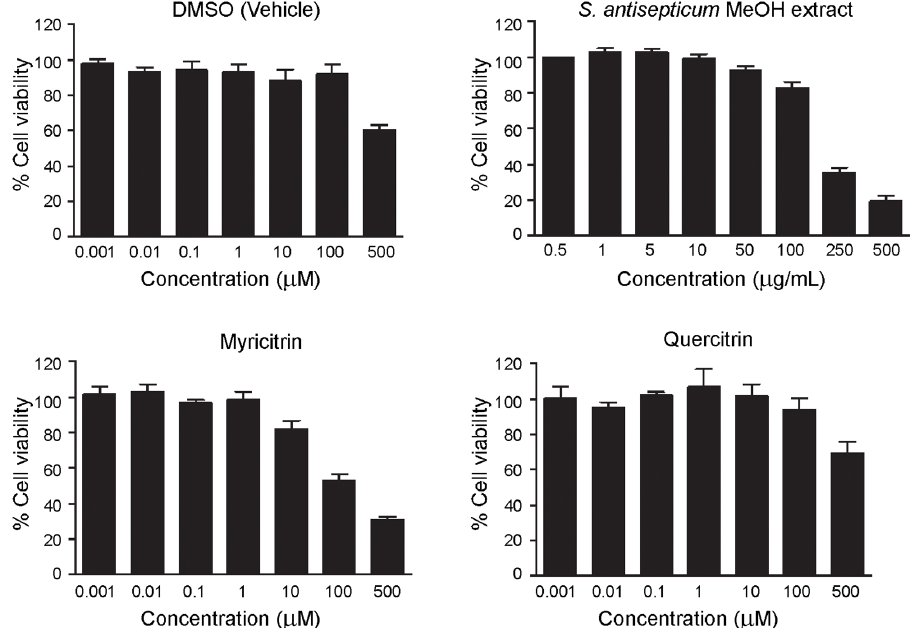
Figure 2. Cytotoxicity profiles of the extract from S. antisepticum and flavonoid glycosides 7 and 8 ; HEK-293 cells were treated with methanol (MeOH) extract (0.5–500 µg/mL), myricitrin ( 7 ) (0.001–500 µM), or quercitrin ( 8 ) (0.001–500 µM) for 36 h. Data are shown as the percentage of cell viability (mean ± SEM) (n = 4).